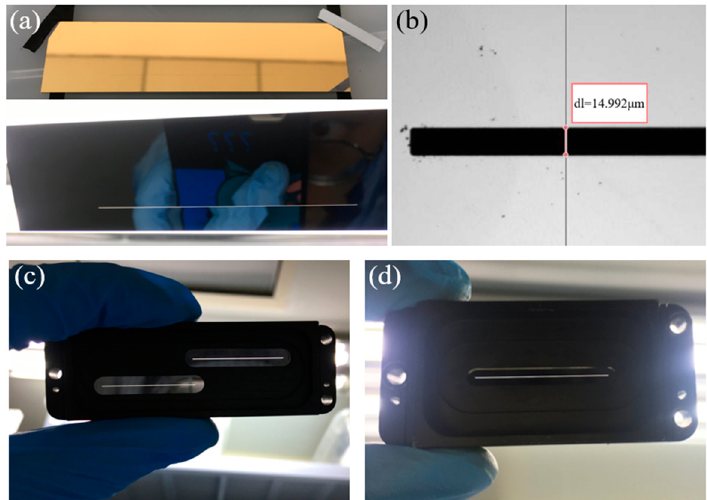
Figure 12. Slits based on silicon. ( a ) B1 and B2 slits, ( b ) 10 × micrograph of B1 slit, ( c ) B3 and B4 slits, ( d ) B5 slit.